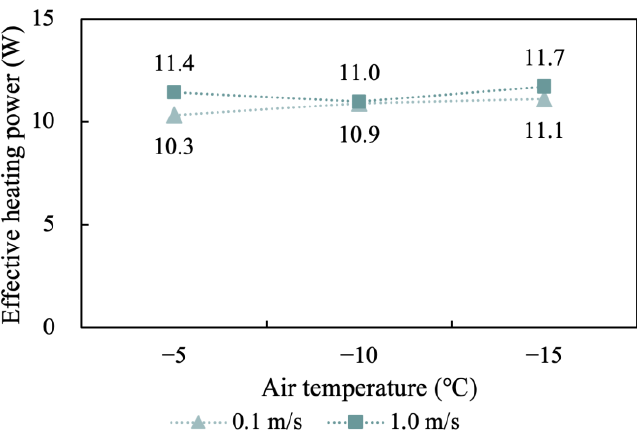
Figure 11. P eff of EHS in different experimental conditions. Table 8. 𝜂 of EHS in different experimental conditions.